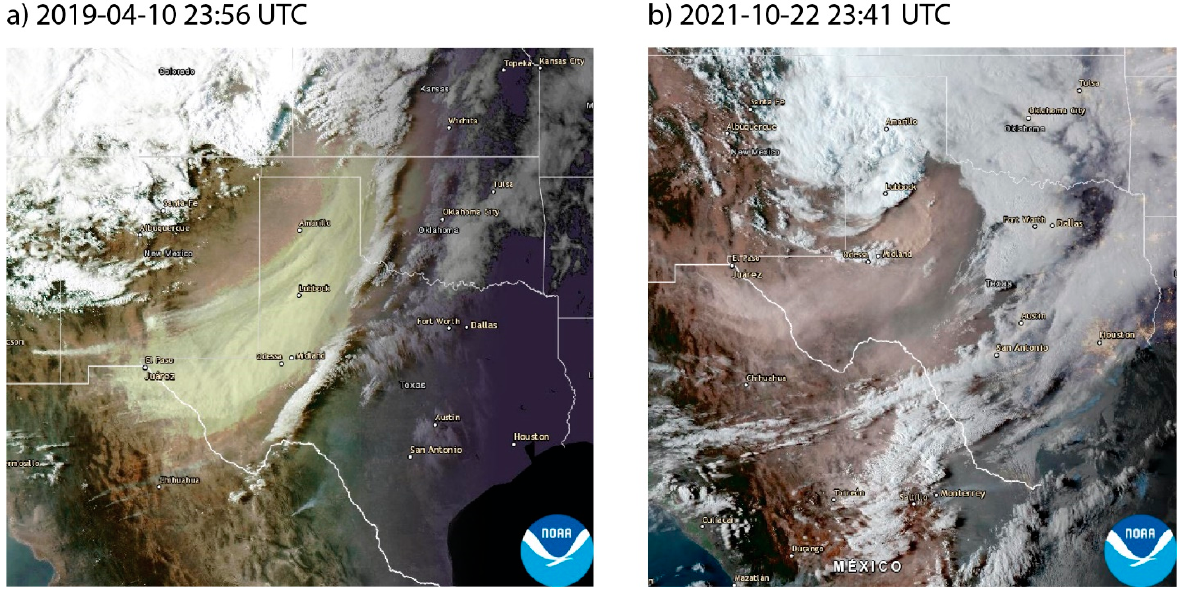
Figure 3. Two examples of recent dust events in Texas and the surrounding region on ( a ) 10 April 2019 at 23:56 UTC and ( b ) 22 October 2021 at 23:41 UTC, captured by the GOES-16 satellite and obtained from AerosolWatch (https://www.star.nesdis.noaa.gov/smcd/spb/aq/AerosolWatch/, accessed on 21 August 2022), showing dust transport from Mexico into Texas ( a , b ) and from Texas into Oklahoma and Kansas ( a ).